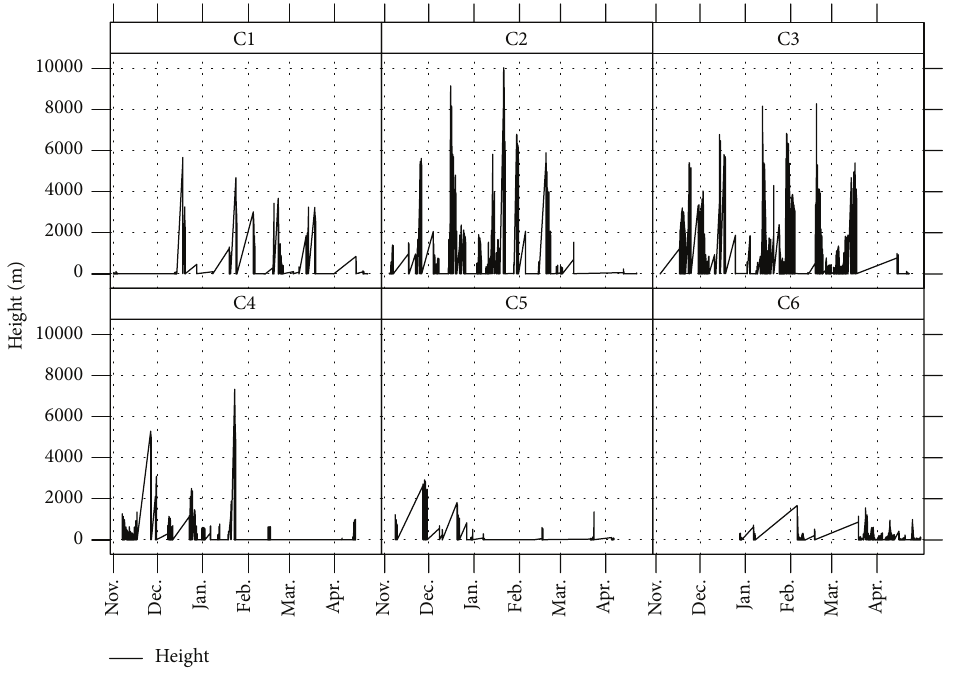
Figure 5: Time-plots of heights of the trajectories shown for each